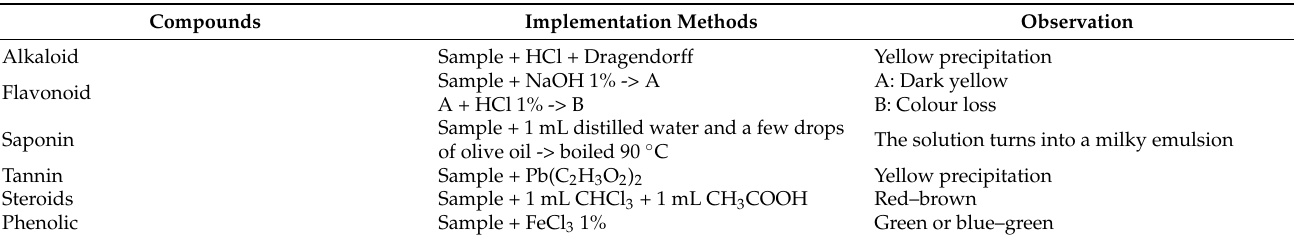
Table 2. Methods for qualitative phytochemical